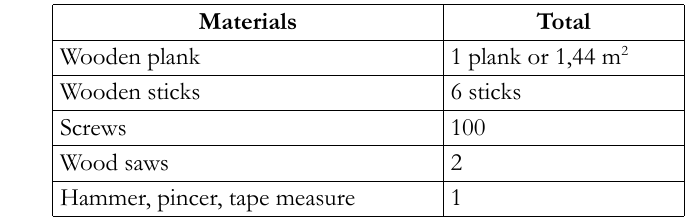
Table 5. Worksheet 4 of